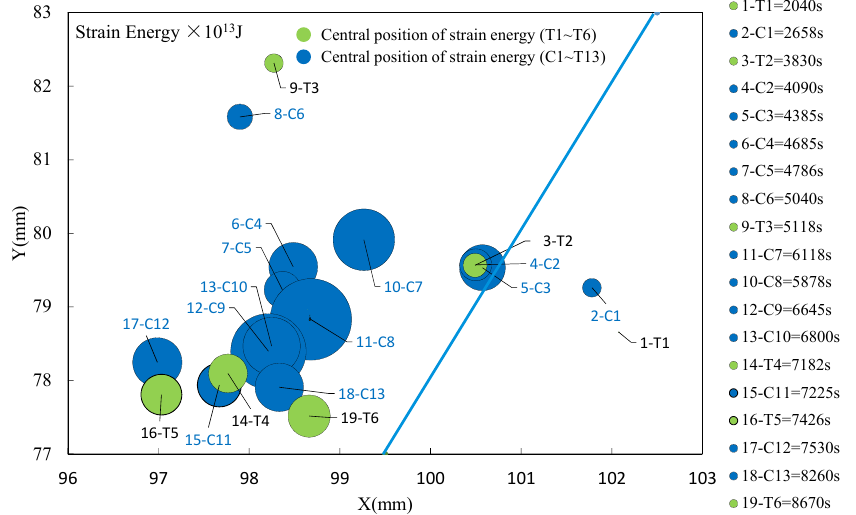
Figure 21. The central position of strain energy in each period.